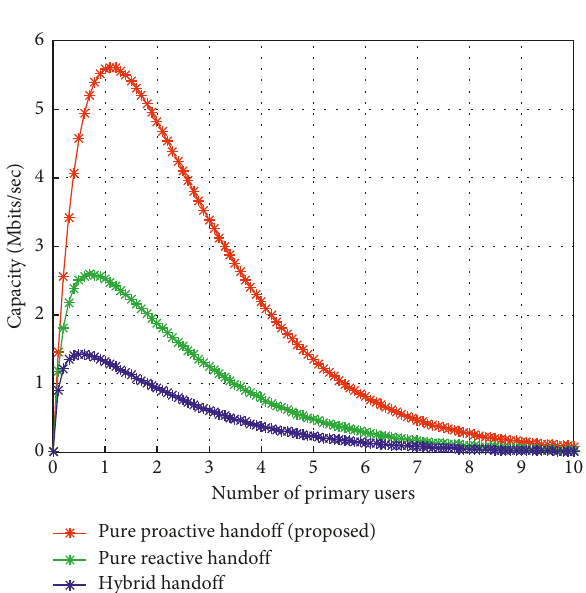
Figure 6: Capacity comparison in the different modes of spectrum